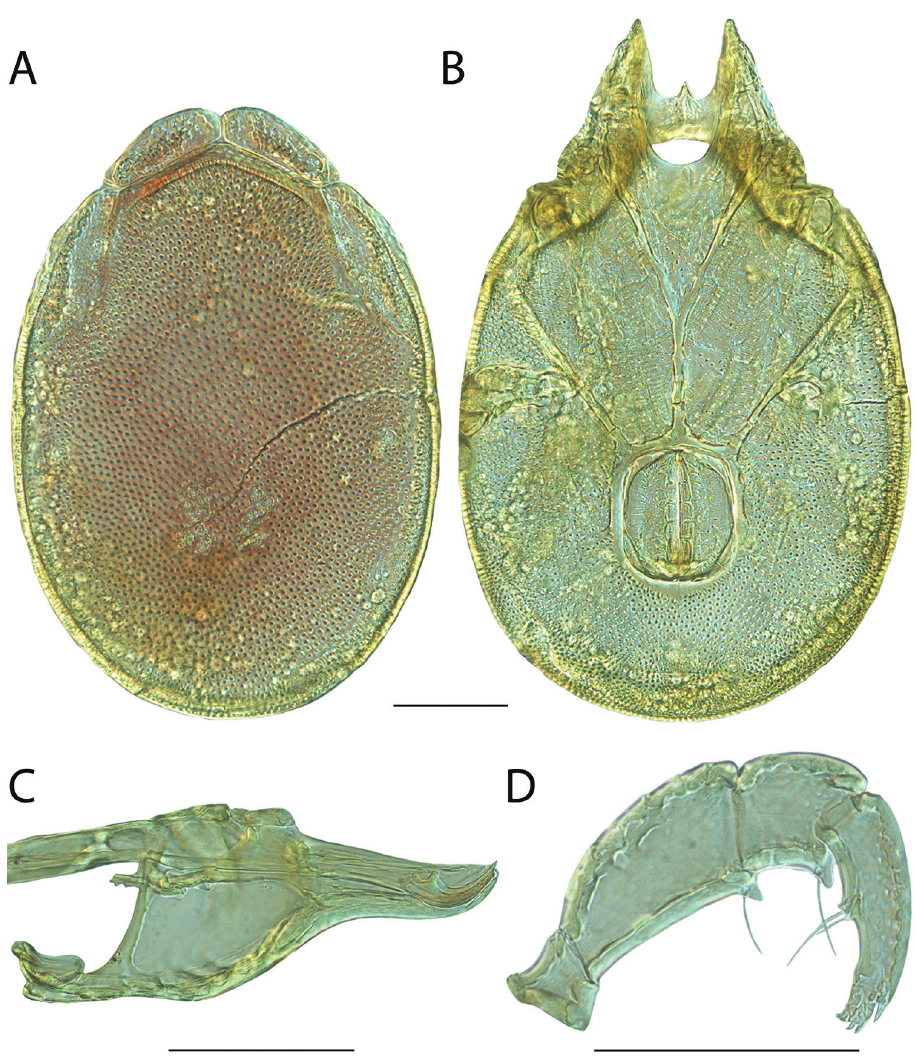
Figure 272. Torrenticola walteri sp. n. male: A dorsal plates B venter (legs removed) C subcapitulum D pedipalp (setae not accurately depicted). Scale = 100